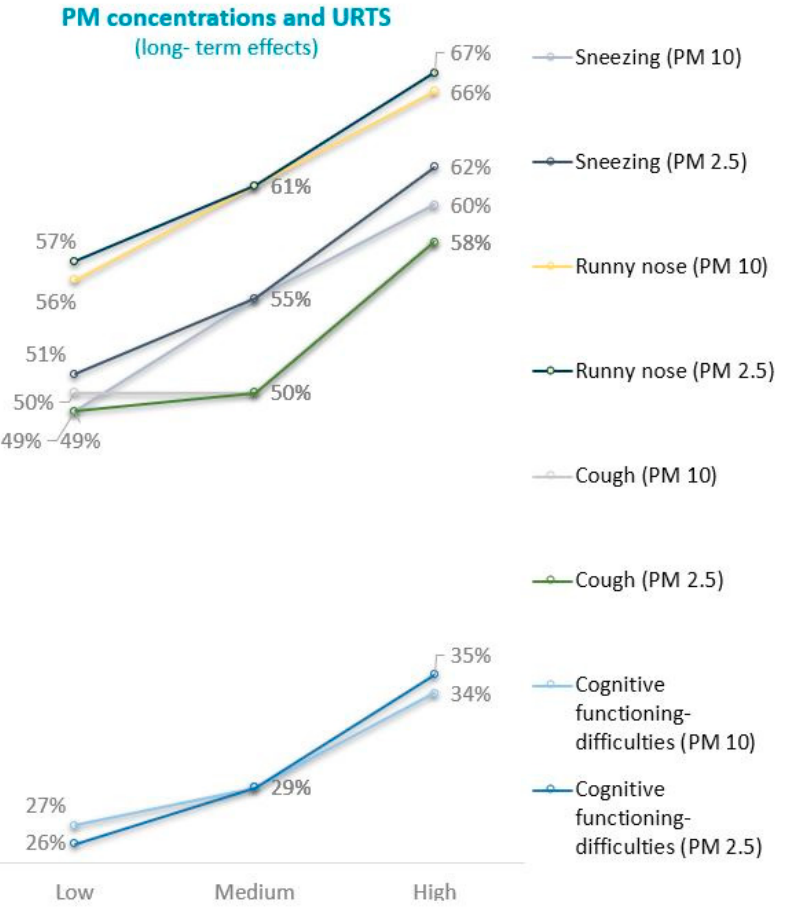
Figure 9. A single time-series figure with prevalence of outcomes long-term lagged mean of PM2.5 and PM10.